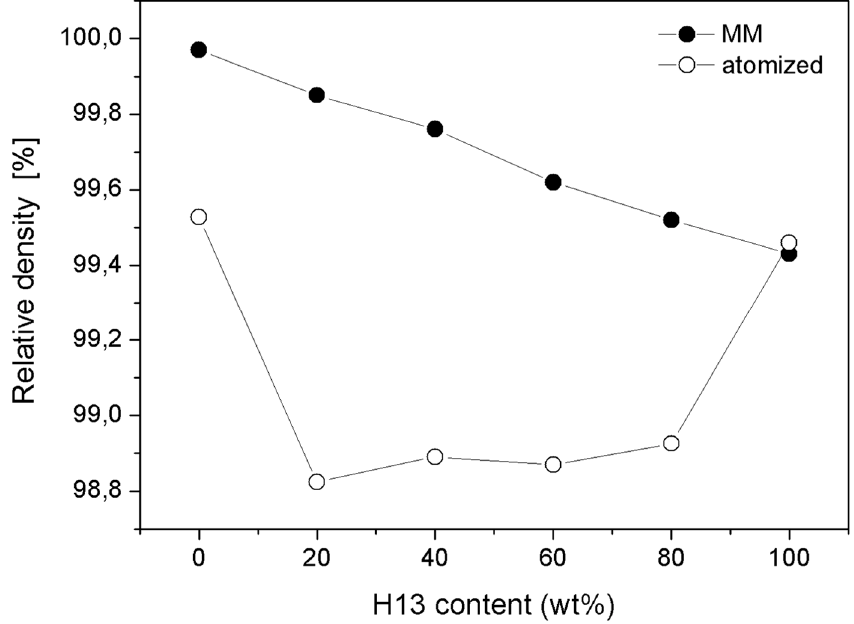
Figure 5. Density and relative density of the sintered specimens as a function of AISI H13 content.